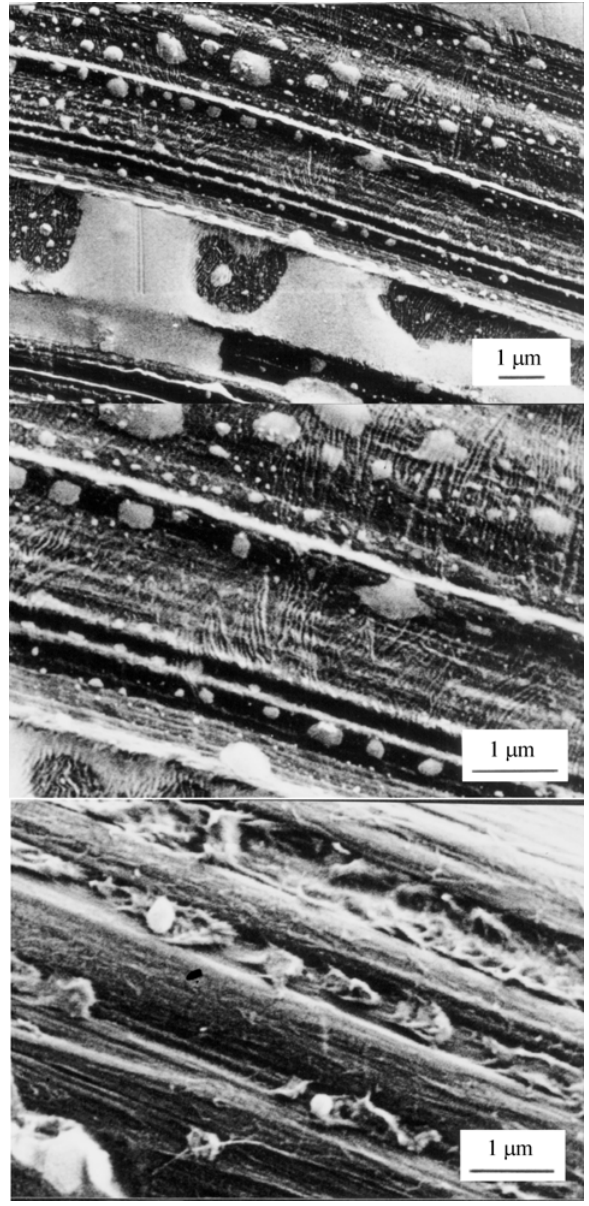
Figure 9. Top view of initial transcrystalline HDPE matrix lamellae from region S 2 (see Fig. 7 for sample location). Magnification 7.500X in (a), 15.000X in (b). For comparison, UHMWPE fiber surface without HDPE in (c). Magnification